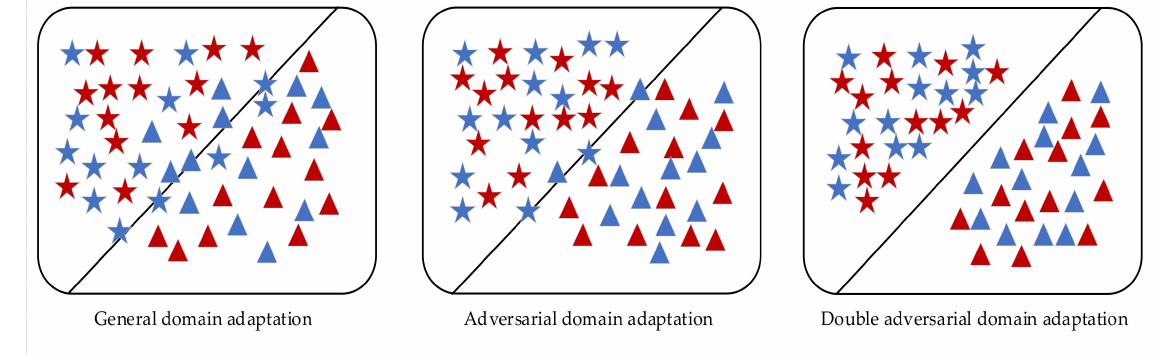
Figure 2. Classification comparison of various domain adaptation